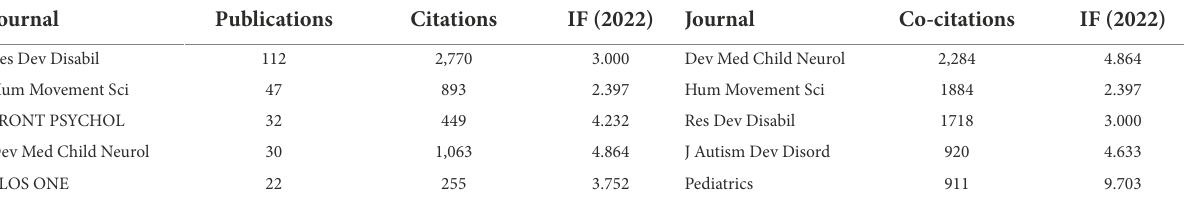
TABLE 3 Number of publications from the top five journals and co-cited